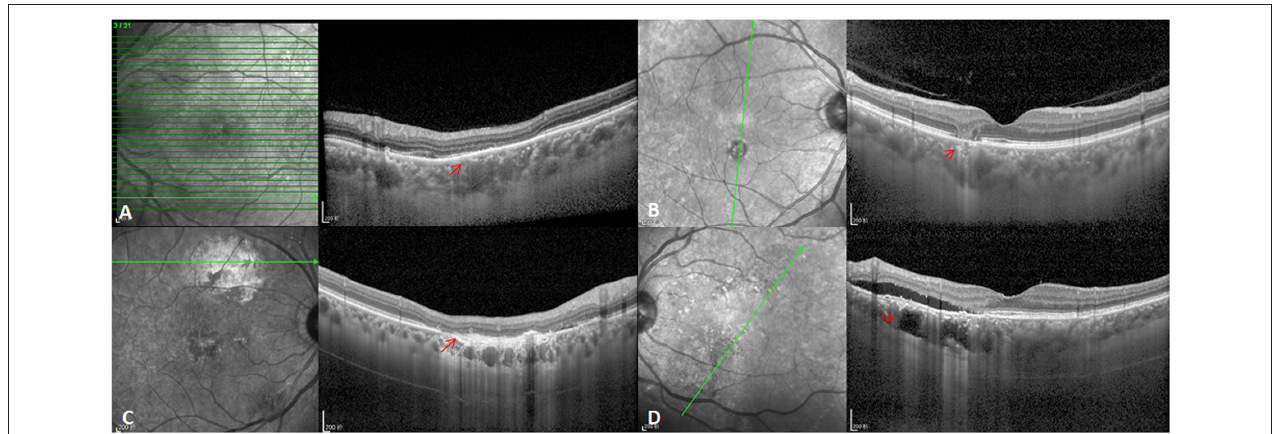
FIGURE 4 | Atrophic lesion types in PSD eyes. (A) CSC-related RPE atrophy lesions (red arrow). (B) GA lesions (red arrow). (C) Simple RPE atrophy (red arrow). (D) Choroidal lipid globulecavern (red